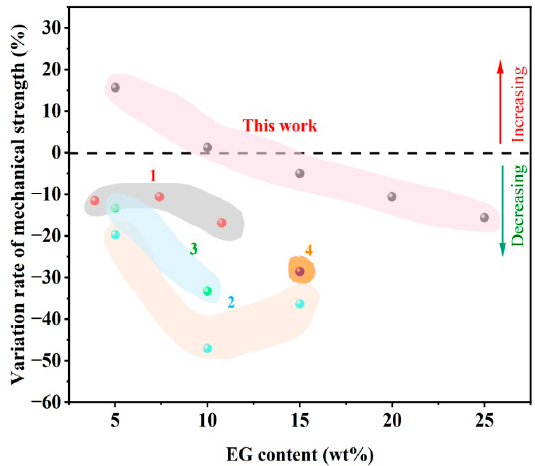
Figure 8. Effect of EG on the mechanical strength of polyurethane composite materials. The repre- sentative previous studies numbered 1 [38], 2 [55], 3 [40], 4 [41] of polyurethane foams are cited and compared here.